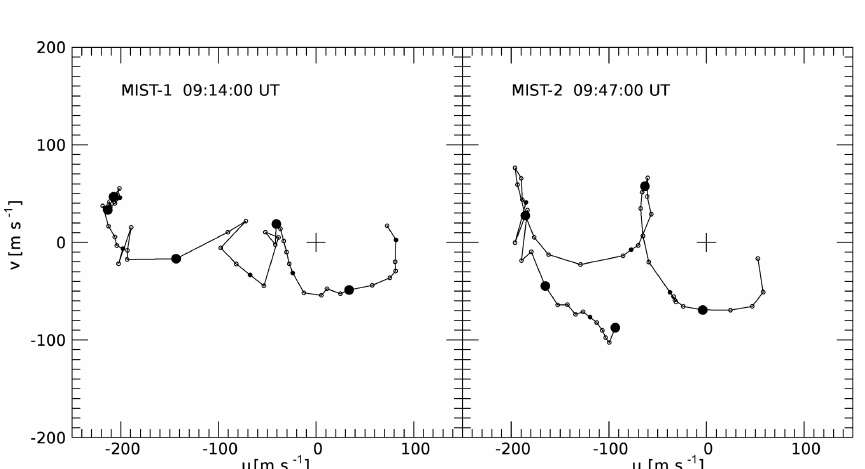
Figure 14. Hodograph projections of the horizontal wind. The lowest altitudes start on the right at positive zonal winds. Small open circles are drawn every 1km and large filled circles every 10km. The first large circle is at 90km. The cross marks the origin (zero